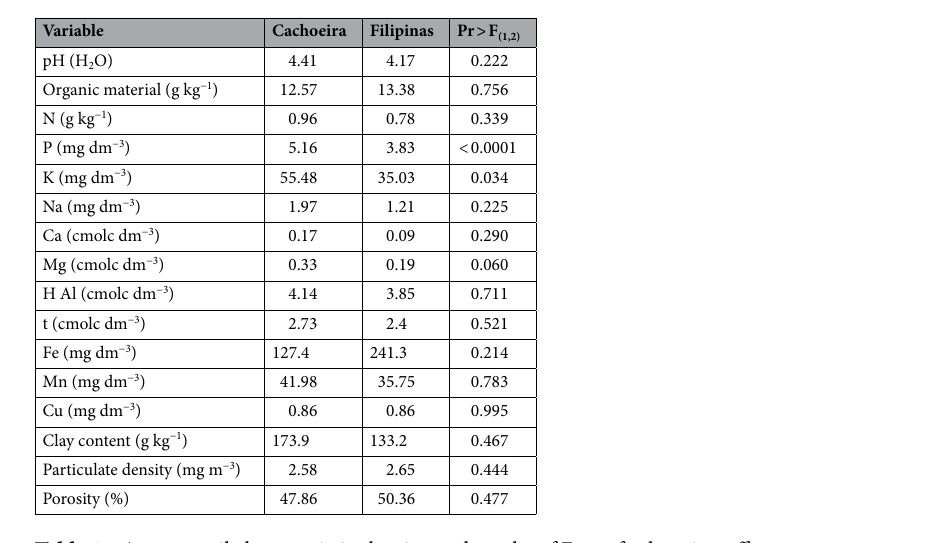
Table 1. Average soil characteristics by site, and results of F-test for location